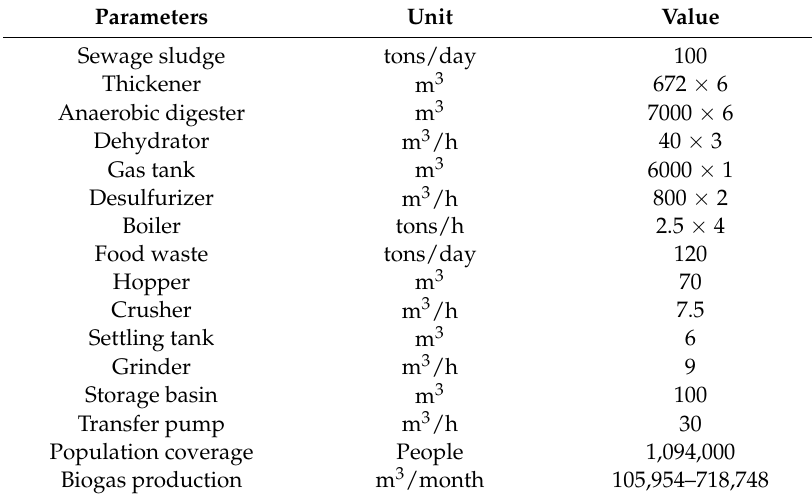
Table 3. Characteristics and operating conditions of the sewage sludge and food waste treatment plant in Busan, Republic of Korea.